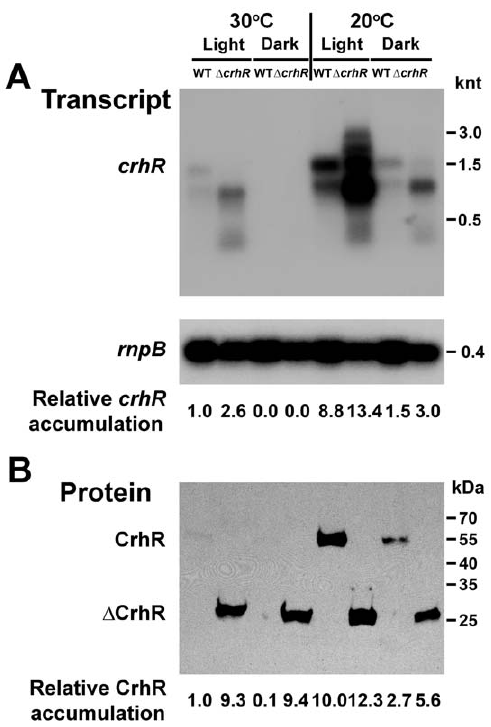
Figure 1. crhR expression in response to abiotic stress. ( A ) Northern analysis. Total RNA (5 m g) was probed with a 93 bp Hinc II- Sac II internal fragment of crhR . Synechocystis cells were grown at 30 u C and stressed by transfer to the dark or 20 u C for 1 h before harvesting at the indicated temperature. Shown below is the stripped blot probed with the Synechocystis rnpB as a control for RNA loading. Transcript abundance was quantified using Image J software Version 1.45 S (NIH, USA) [32], crhR transcript abundance was normalized using